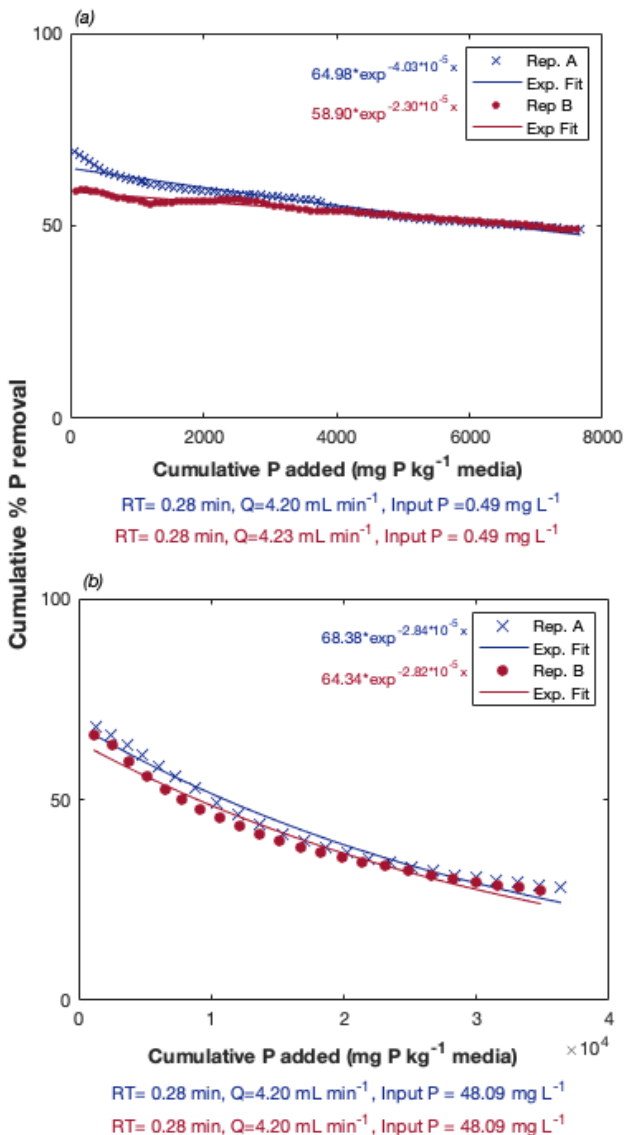
Figure 2. Preliminary evaluation of phosphorus (P) removal ability of Alcan in flow-through experiments conducted at a residence time (RT) of 0.28 min and inflow P concentrations of ( a ) 0.5 mg L − 1 and ( b ) 50 mg L − 1 . Cumulative P removal is plotted as a function of cumulative P